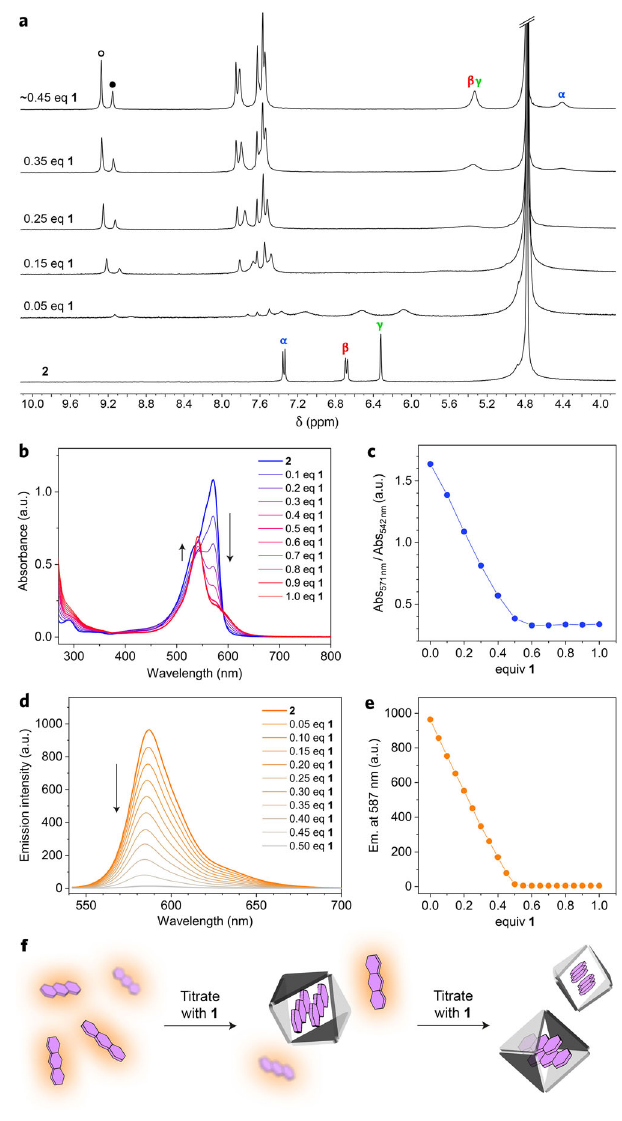
Fig. 2 Spectroscopic characterization of the resoru fi n complex. a Bottom to top: 1 H NMR spectra of 2 in the presence of increasing amounts of cage 1 (400 MHz, D 2 O, 298 K). b A series of UV – Vis absorption spectra accompanying the titration of 2 with cage 1 . No changes in the >400nm region are visible beyond ~0.5 equiv of 1 , indicating a 2:1 stoichiometry of the complex. c Decrease in the ratio of absorbance at 571 nm (Abs 571nm ) (high for 2 ; low for 2 2 ⊂ 1 ) to absorbance at 542 nm (Abs 542nm ) (high for 2 2 ⊂ 1 ; low for 2 ) as a function of the amount of 1 added. d A series of fl uorescence spectra ( λ = 530 nm) accompanying the titration of 2 with exc cage 1 . e Decrease of emission at 587 nm as a function of the amount of 1 added. f Cartoon representation of fl uorescence quenching due to inclusion complex formation during the titration of 2 with cage 1